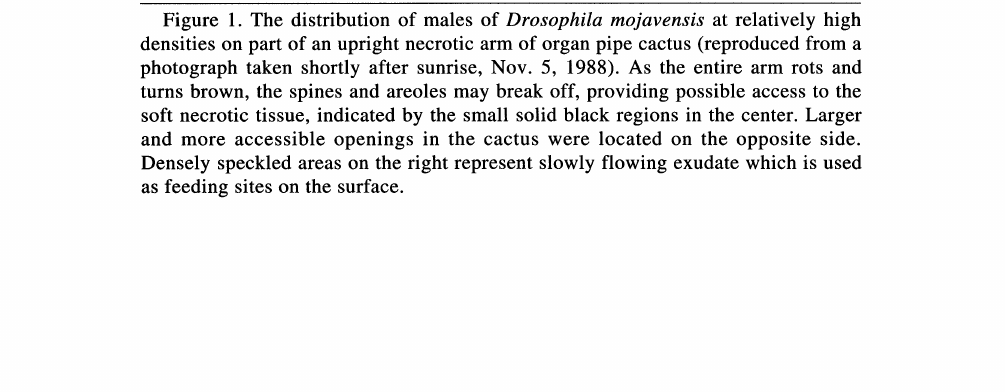
Figure 1. The distribution of males of Drosophila mojavensis at relatively high densities on part of an upright necrotic arm of organ pipe cactus (reproduced from a photograph taken shortly after sunrise, Nov. 5, 1988). As the entire arm rots and turns brown, the spines and areoles may break off, providing possible access to the soft necrotic tissue, indicated by the small solid black regions in the center. Larger and more accessible openings in the cactus were located on the opposite side. Densely speckled areas on the right represent slowly flowing exudate which is used as feeding sites on the